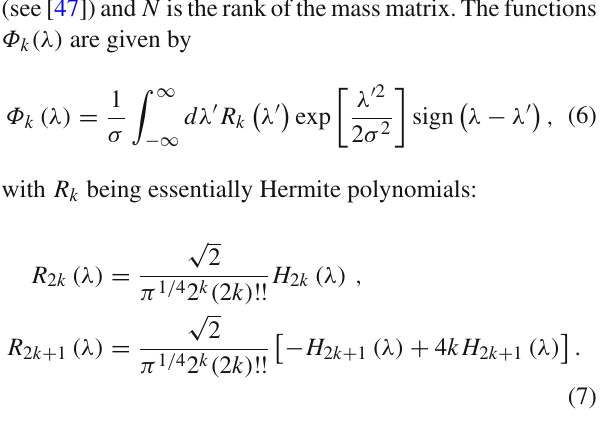
!|ˆ a | 2 N / 2 − 1 N , ˆ a is a constant that depends on N N Z